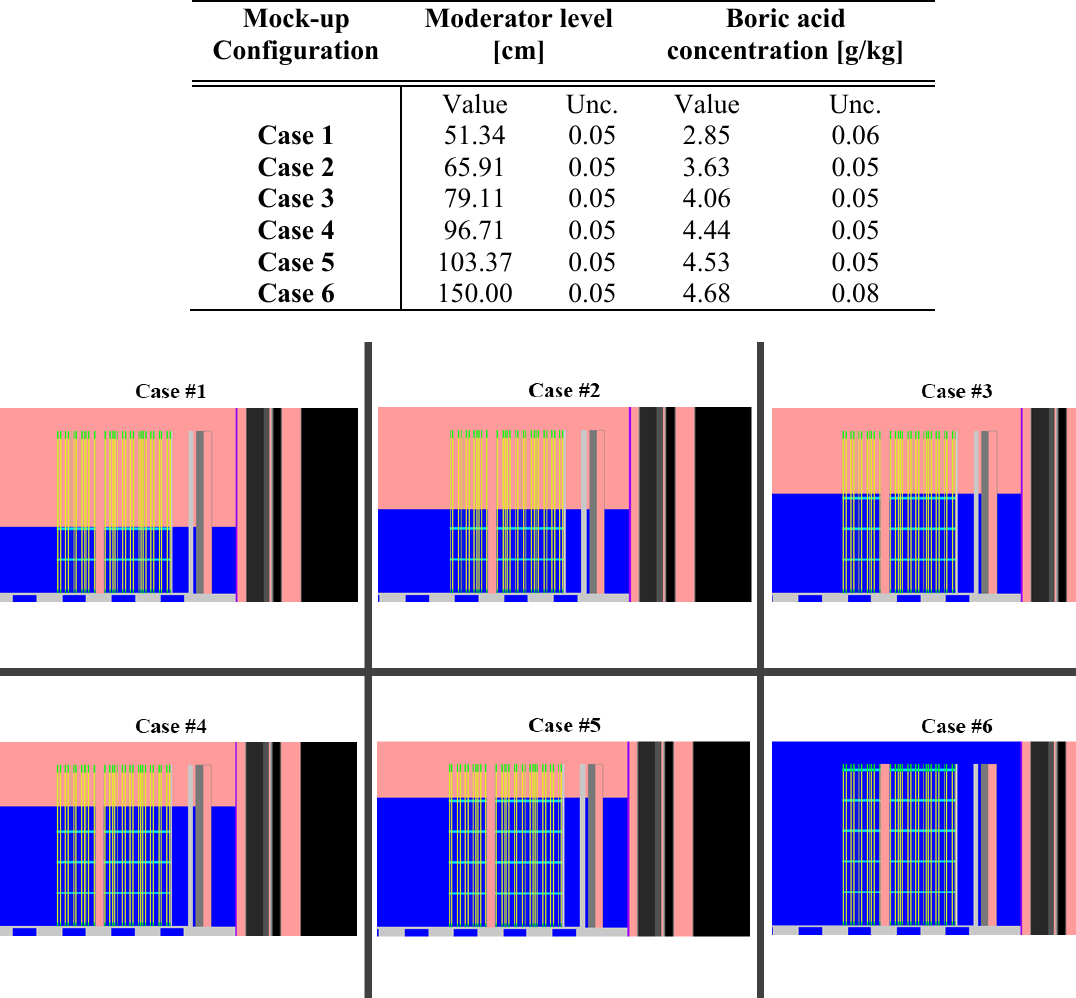
Figure 2. Axial view (YZ-plane) of the six VVER-1000 mock-up critical